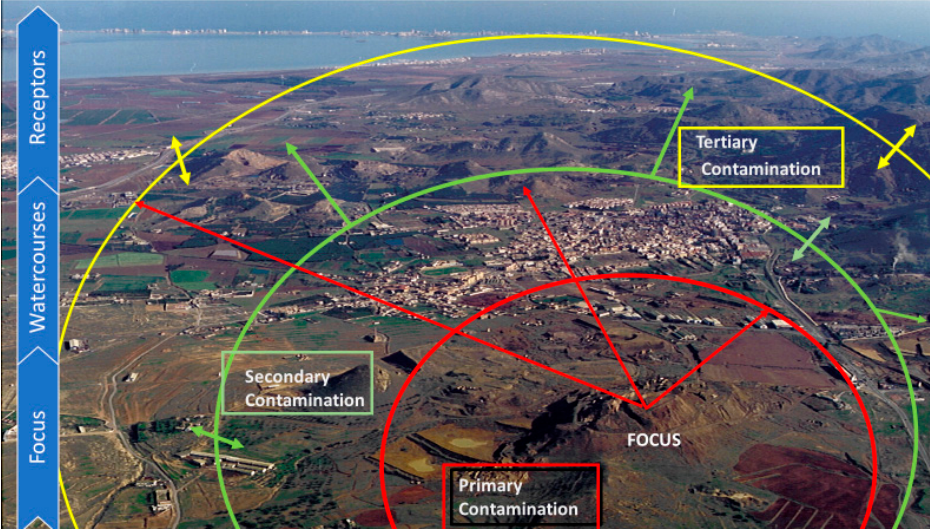
Figure 6. Focus and levels of contamination in the study area.